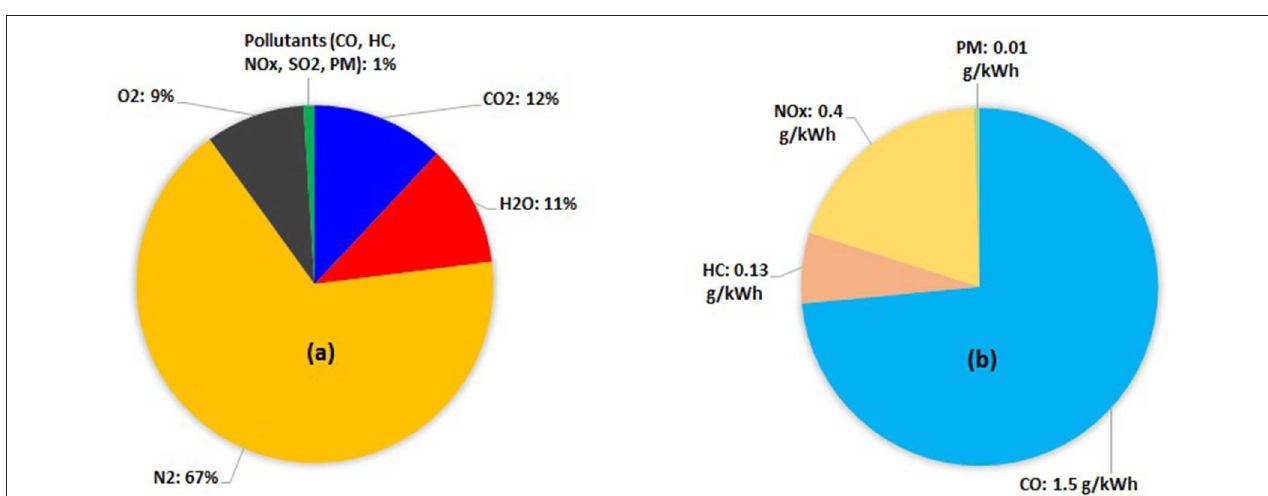
FIGURE 1 | (a) Composition of exhaust gas from diesel engine; (b) Euro emissions standard for heavy duty vehicles.